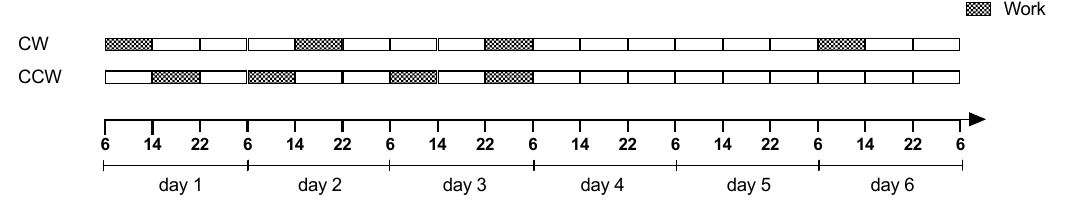
Figure 1. Work schedule of CW (Clockwise) and CCW (counterclockwise) rotating nurses over an entire shift cycle.